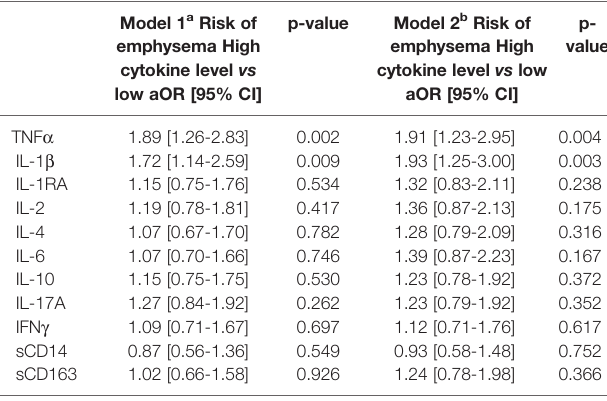
TABLE 3 | Multivariable logistic regression analyses for the association between elevated cytokine concentration (above the 75 th percentile) and emphysema in PLWH.